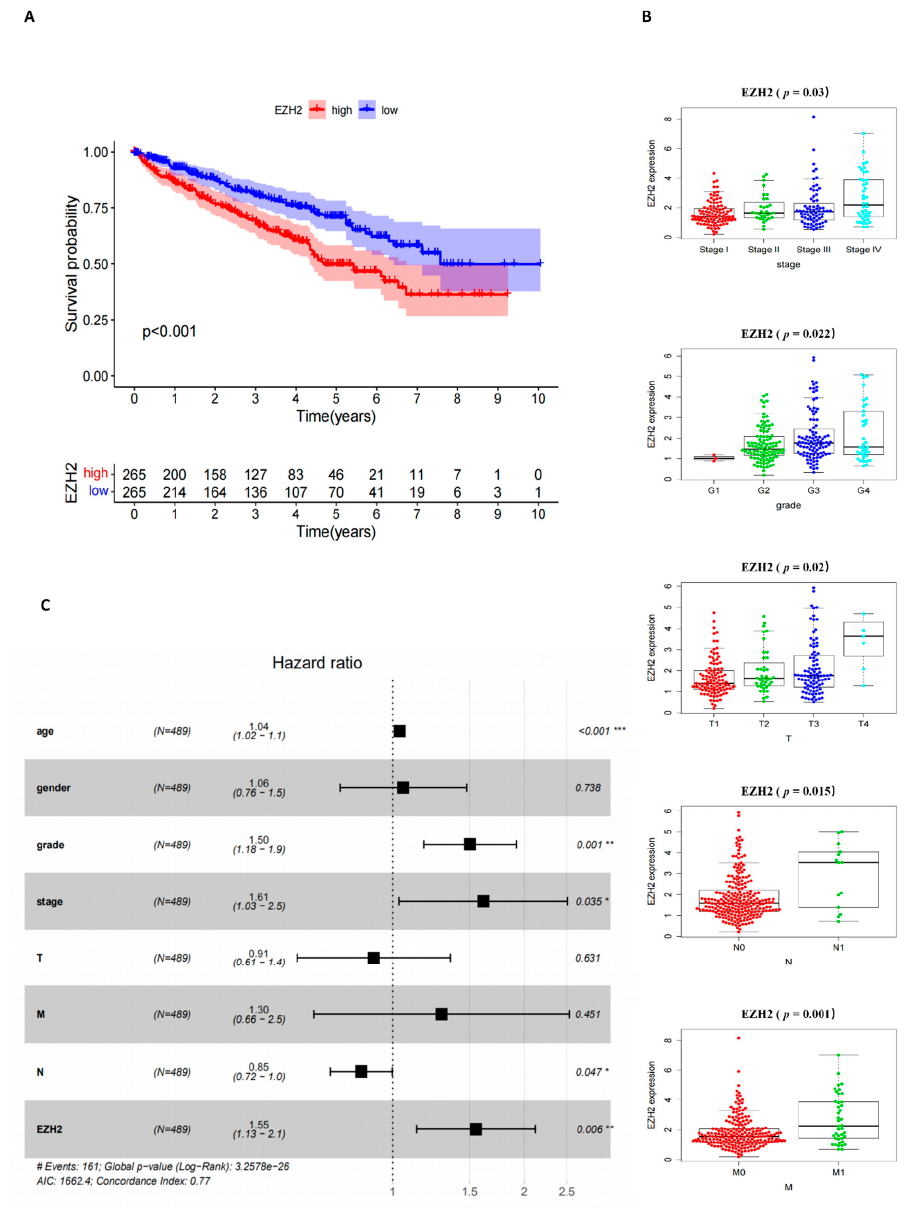
Figure 4. The correlation of EZH2 expression with clinicopathological characteristics: ( A ) Kaplan–Meier survival analysis for the KIRC patients grouped into high or low score in EZH2 expression determined by the comparison with the median, p < 0.001 by log-rank test. ( B ) Distribution of EZH2 expression concerning the stage, grade, and T classification, the p -values p = 0.003, 0.022, and 0.002, respectively, were calculated by the Kruskal–Wallis rank sum test, distribution of scores in M and N classification, the p -values p = 0.001 and 0.0015, respectively, were calculated by the Wilcoxon rank sum test. ( C ) The multivariate Cox regression analysis of the risk score, age, gender, grade, and TNM stage was used to evaluate the independent prognostic value of EZH2. * p < 0.05, ** p < 0.01, *** p <